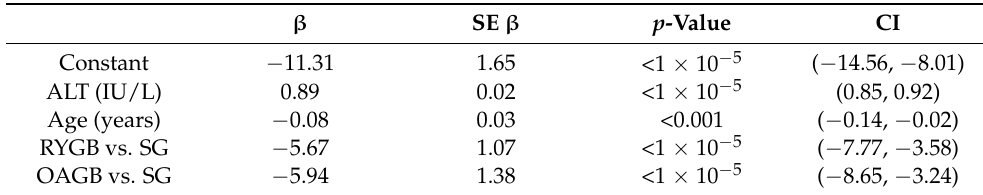
Table 3. Backwards elimination multivariate linear regression model for the change in ALT levels in patients with abnormal pre-surgical ALT two years after bariatric surgery.